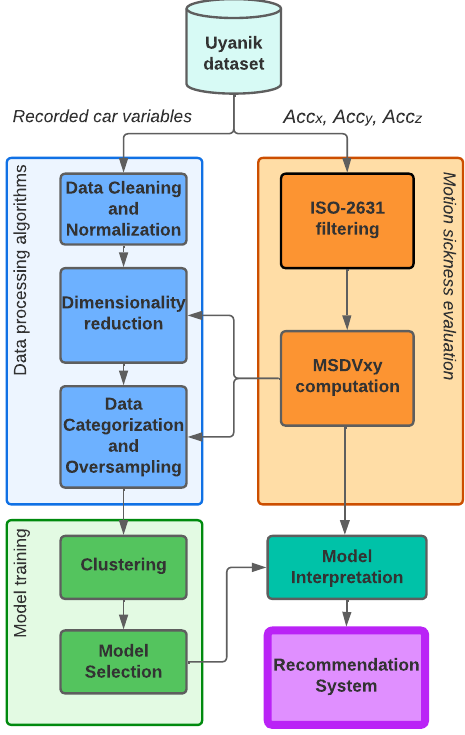
Figure 5. Comfort-oriented processing methodology applied to the Uyanik